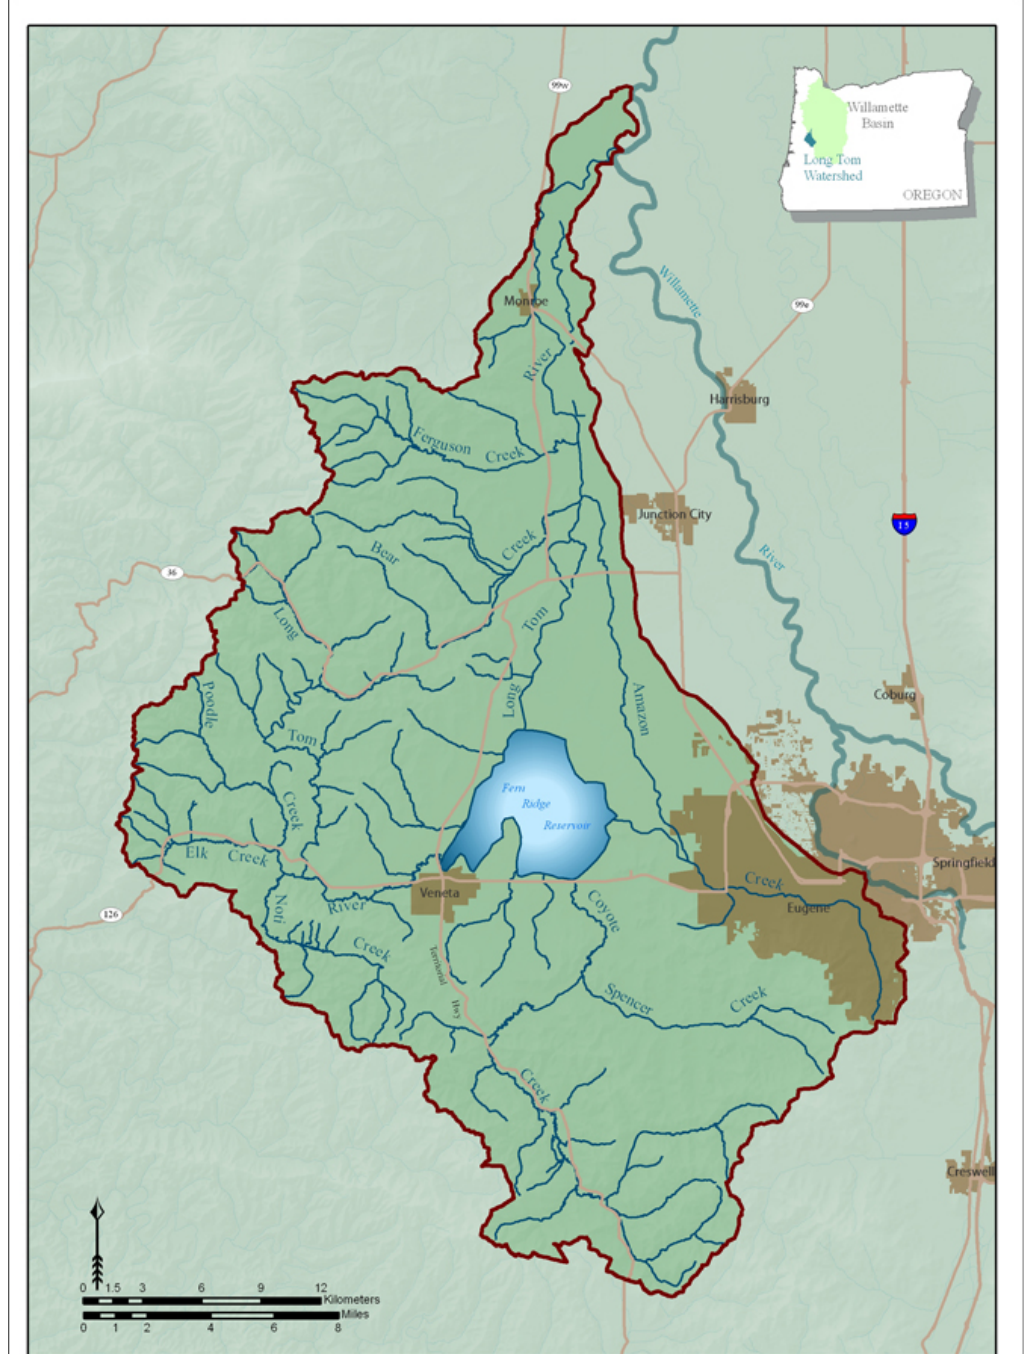
Fig. 1. Map of the Long Tom River Watershed in the Willamette River valley,